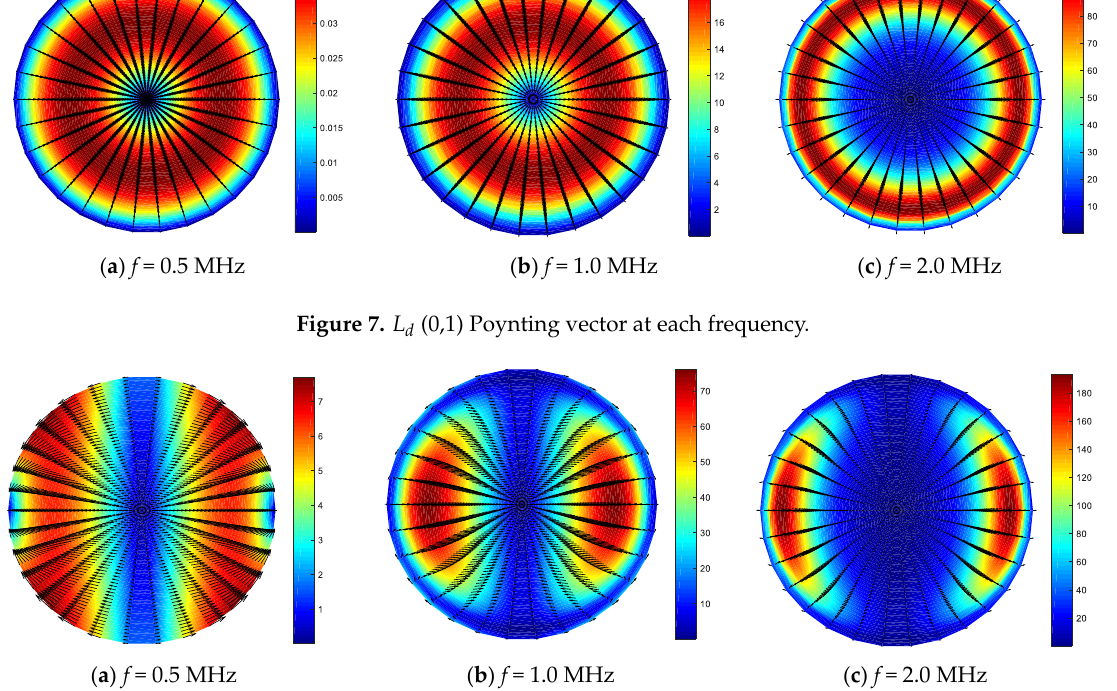
Figure 8. F d (1,1) Poynting vector at each frequency.